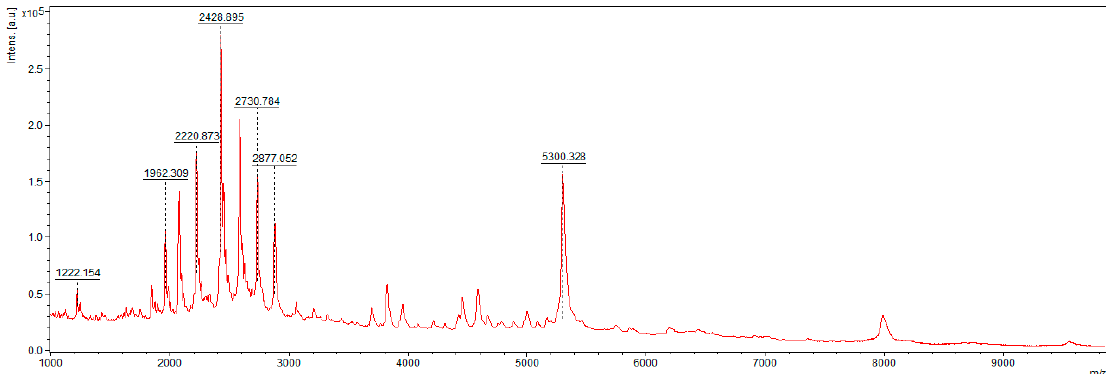
Figure 2. Spectrum obtained for casein at low molecular masses (1–10 kDa) using HCCA matrix.